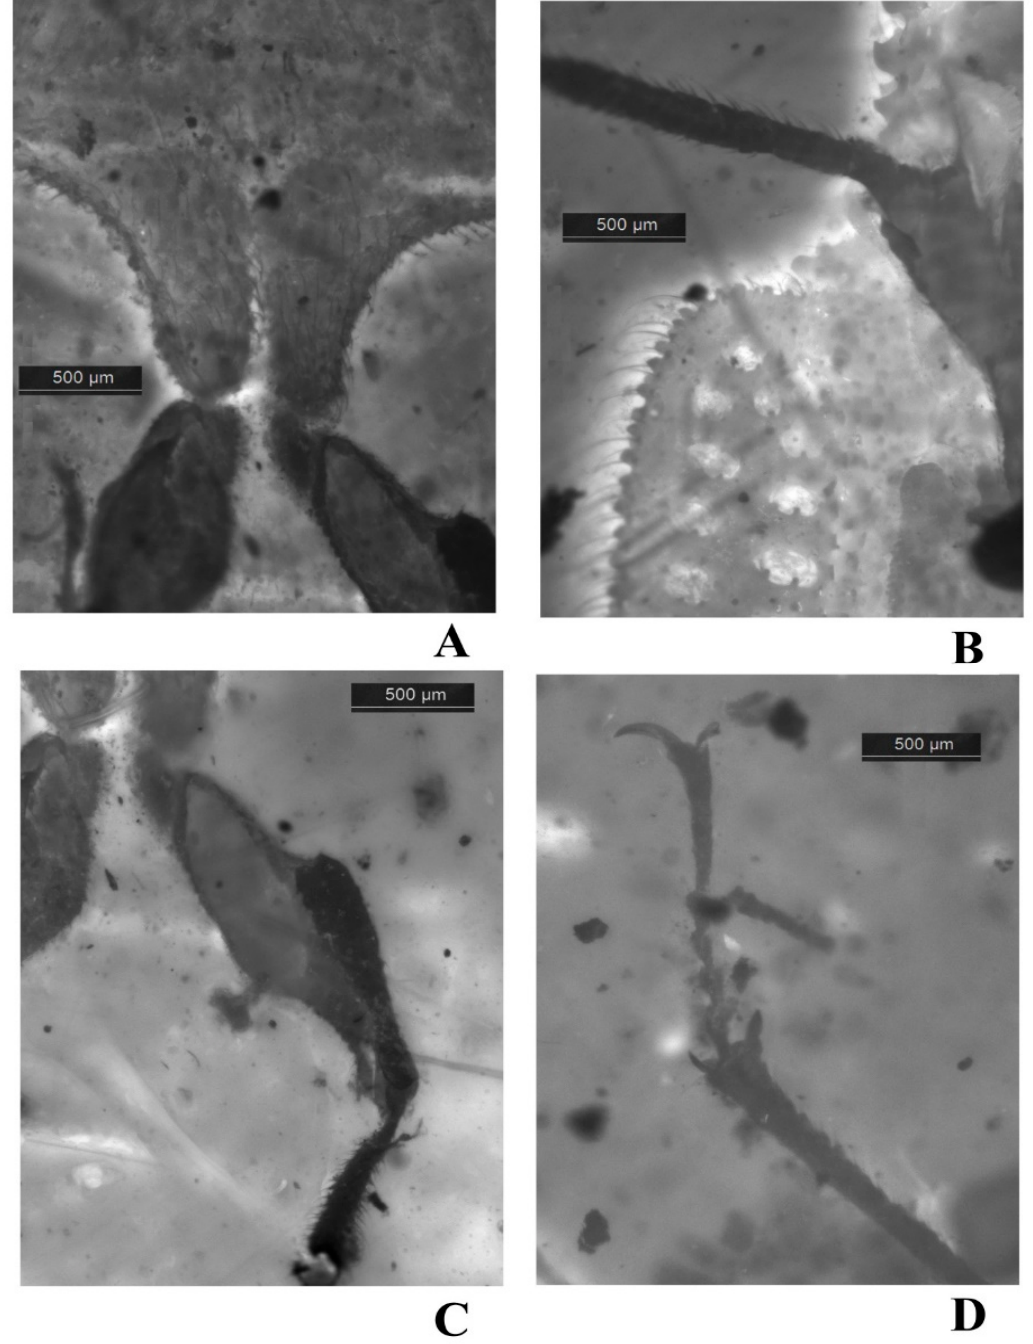
Figure 6. Ommatinae (Cupedidae): Burmocoleus prisnyi sp. nov. , holotype ZIN Cuped 002 (Lower/Upper Cretaceous: Upper Albian/Lower Cenomanian; Myanmar, Kachin, Burmese amber); fluorescent microscopy with filter set N21: A —metacoxa, B —lateral part of elytral base, ventral, C — metafemur and metatibia, ventral, D —protibia and protarsus; length of inclusion 14.8 mm; scale for each picture provided; original.